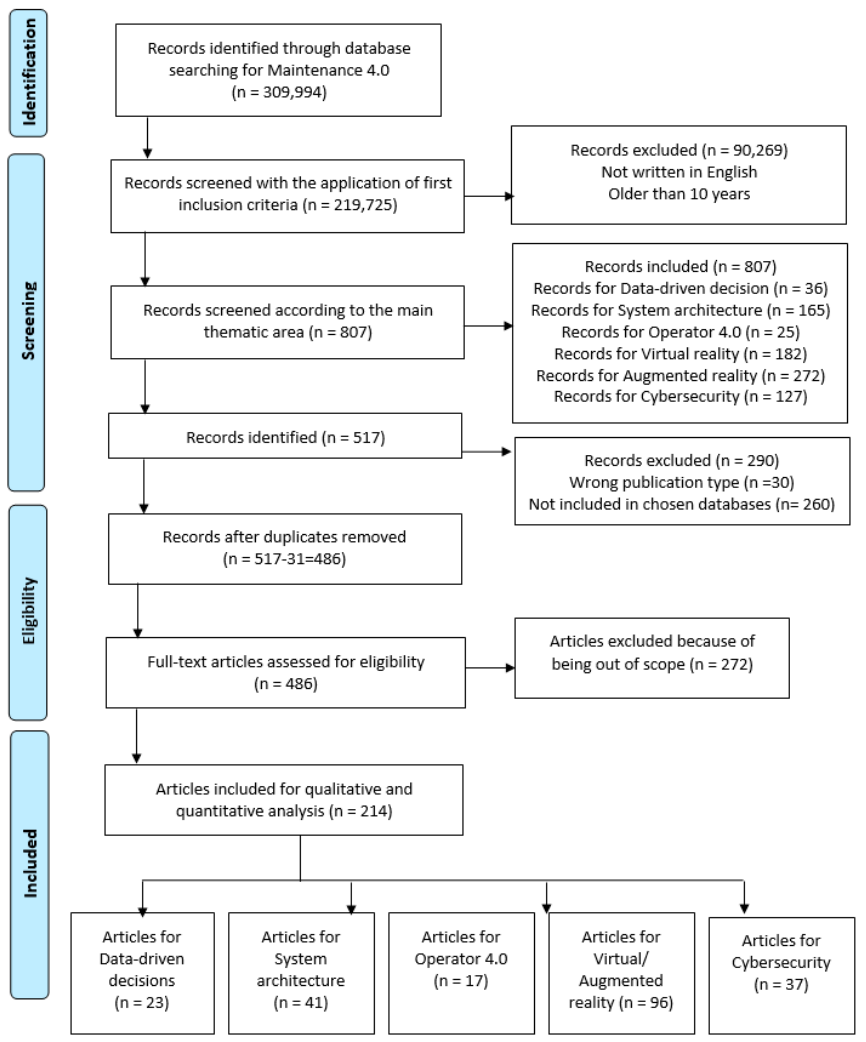
Figure 9. PRISMA-based flowchart of the systematic selection of the relevant studies in the analyzed research area. Source: own contribution based on [93]. research area. Source: own contribution based on